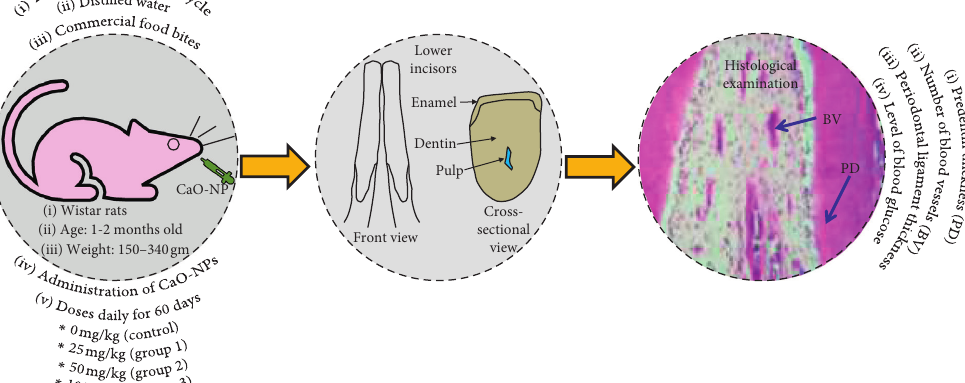
Figure 1: Experimental design to assess the effects of CaO nanoparticle (NP) administration on dentinogenesis of Wistar rats.